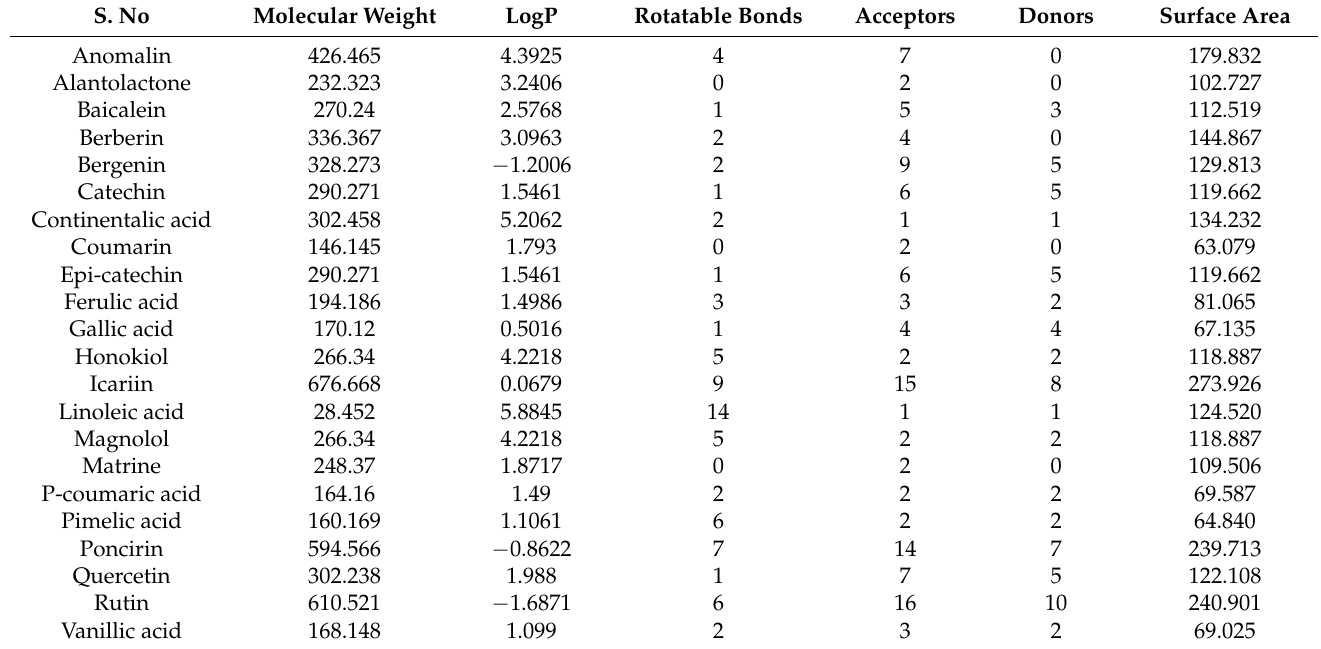
Table 1. The analysis of the physico-chemical properties of the selected compounds using computa- tional